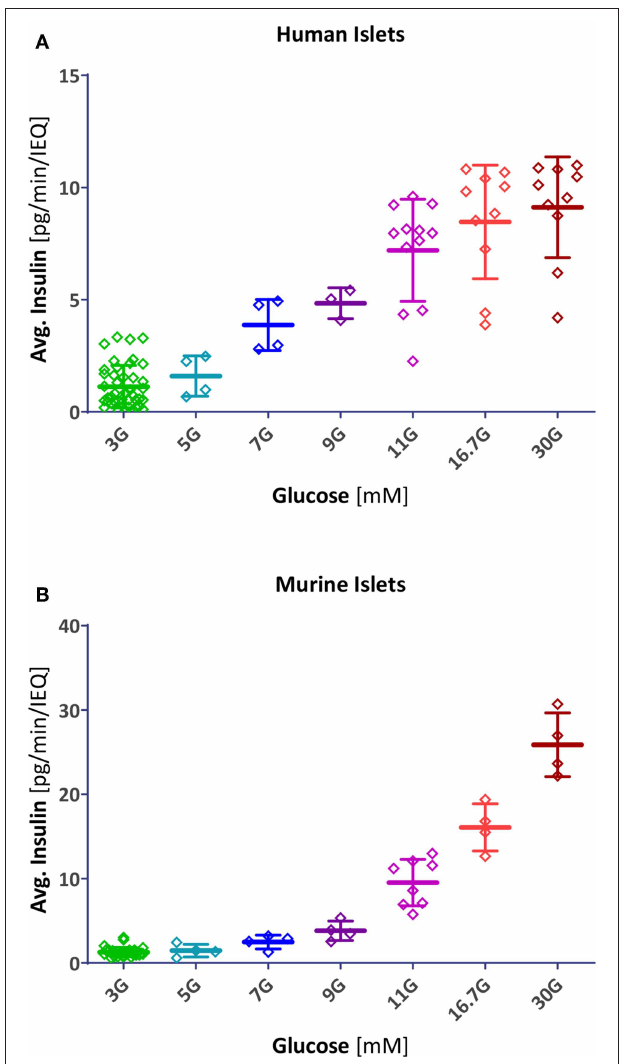
FIGURE 4 | Scatter plot of insulin secretion in response to different glucose concentrations. Data points represent the average insulin secreted by each individual human (A) and mouse (B) islet sample (pg/min/IEQ; first- and second phase combined). Lines indicate group average and SD.